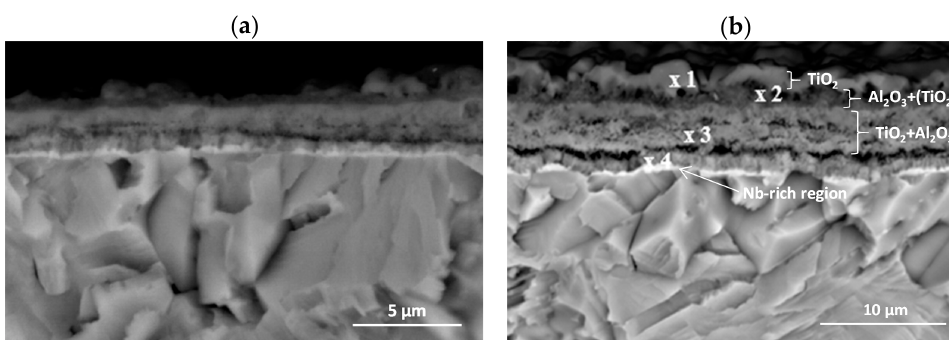
Figure 8. SEM-BSE images of Ti–46Al–7Nb–0.7Cr–0.1Si–0.2Ni alloy after cyclic oxidation at ( a ) 875 °C [26]; ( b ) 925 °C (surface prepared by grinding).